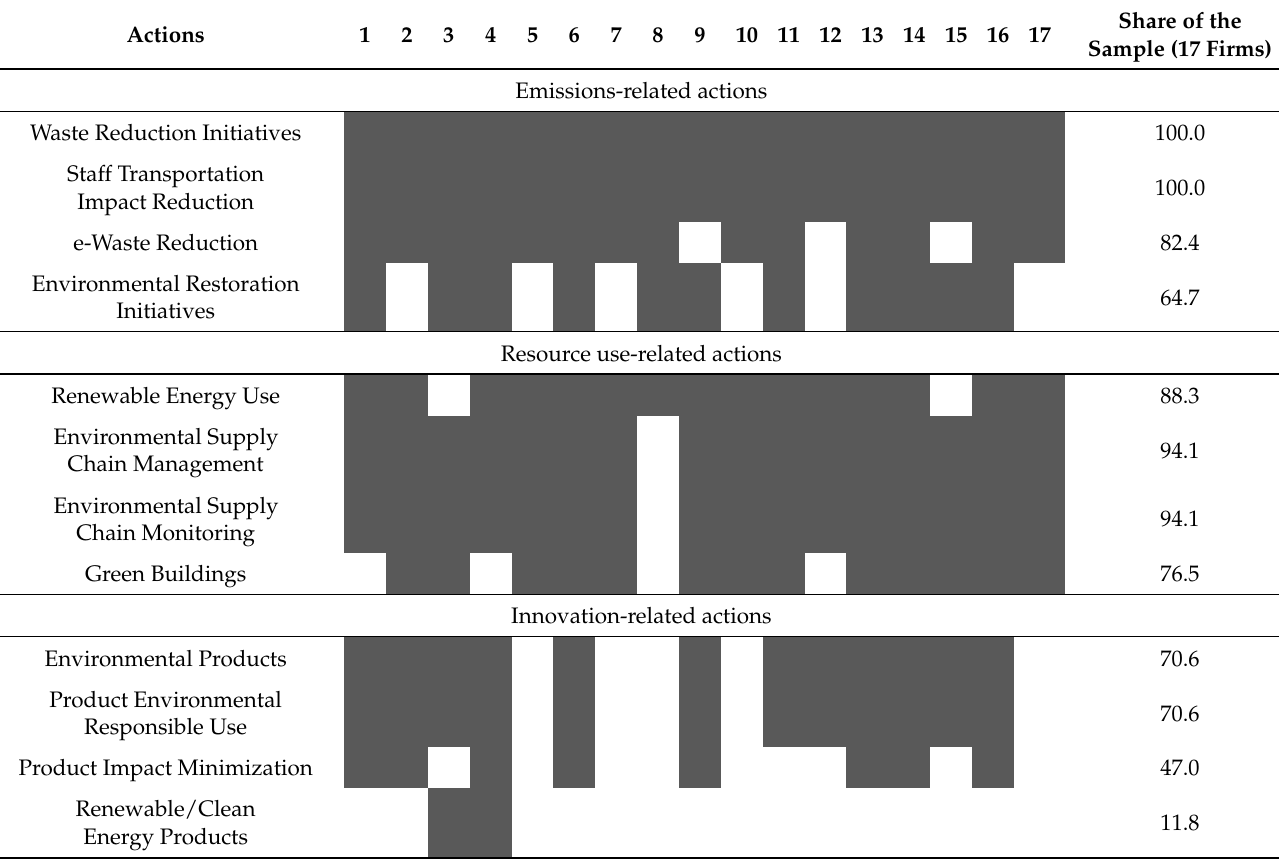
Table 4. Companies reporting different actions in the financial year